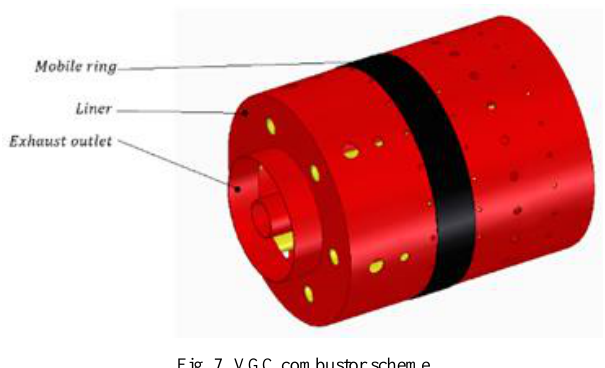
Fig. 7. VGC combustor scheme